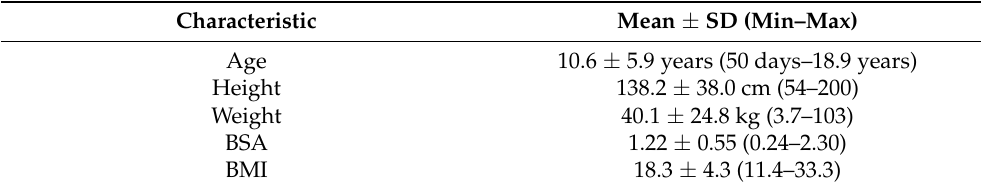
Table 1. Patients’ characteristics (116 examinations).